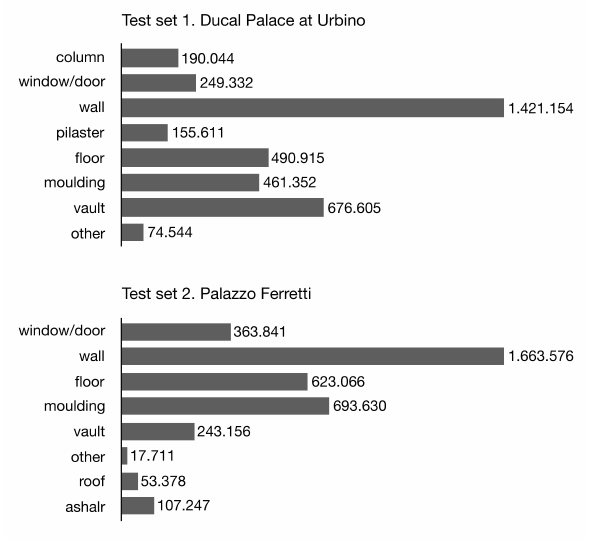
Figure 4. Number of points per class in the two test point